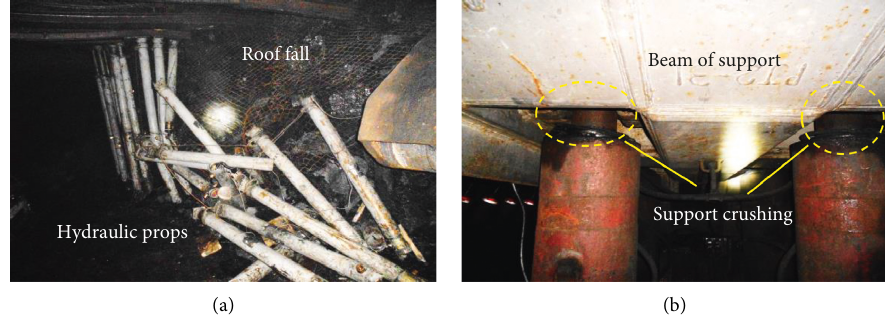
Figure 1: Roof falling and support crushing accidents occurring in the recovery